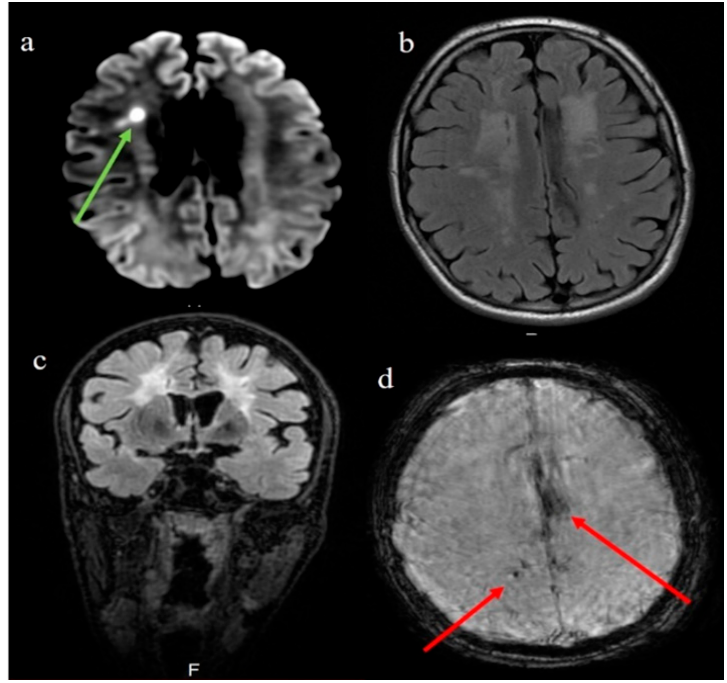
Figure 2. Second brain MRI (1 year later). In the image “ a ” the DWI sequence shows a restricted diffusion in the right periventricular area compatible with subacute ischemic lesion (green arrow); Flair sequences in images “ b ” and “ c ” show a mildly more extensive subcortical leukoencephalopathy; in the image “ d ” SWI sequence highlights the left superficial hemosiderosis in the brain sulci at convexity (red arrow) with right microbleeds (red arrow).